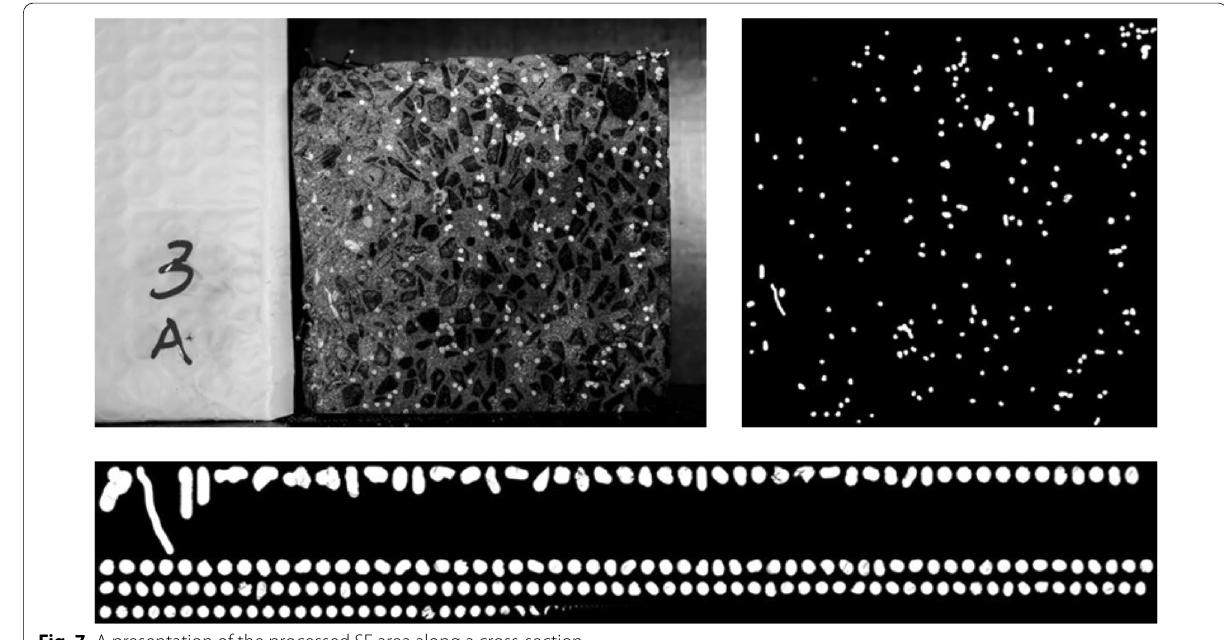
Fig. 7 A presentation of the processed SF area along a cross-section